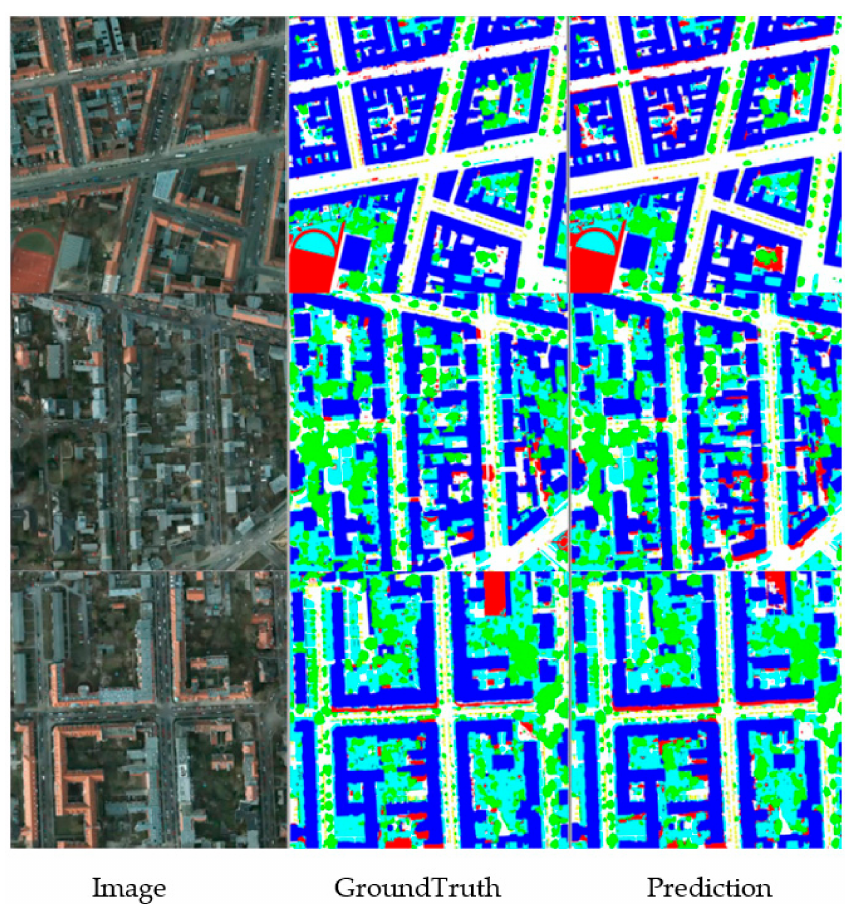
Figure 7. Visualization result of MFNet in the Potsdam dataset.